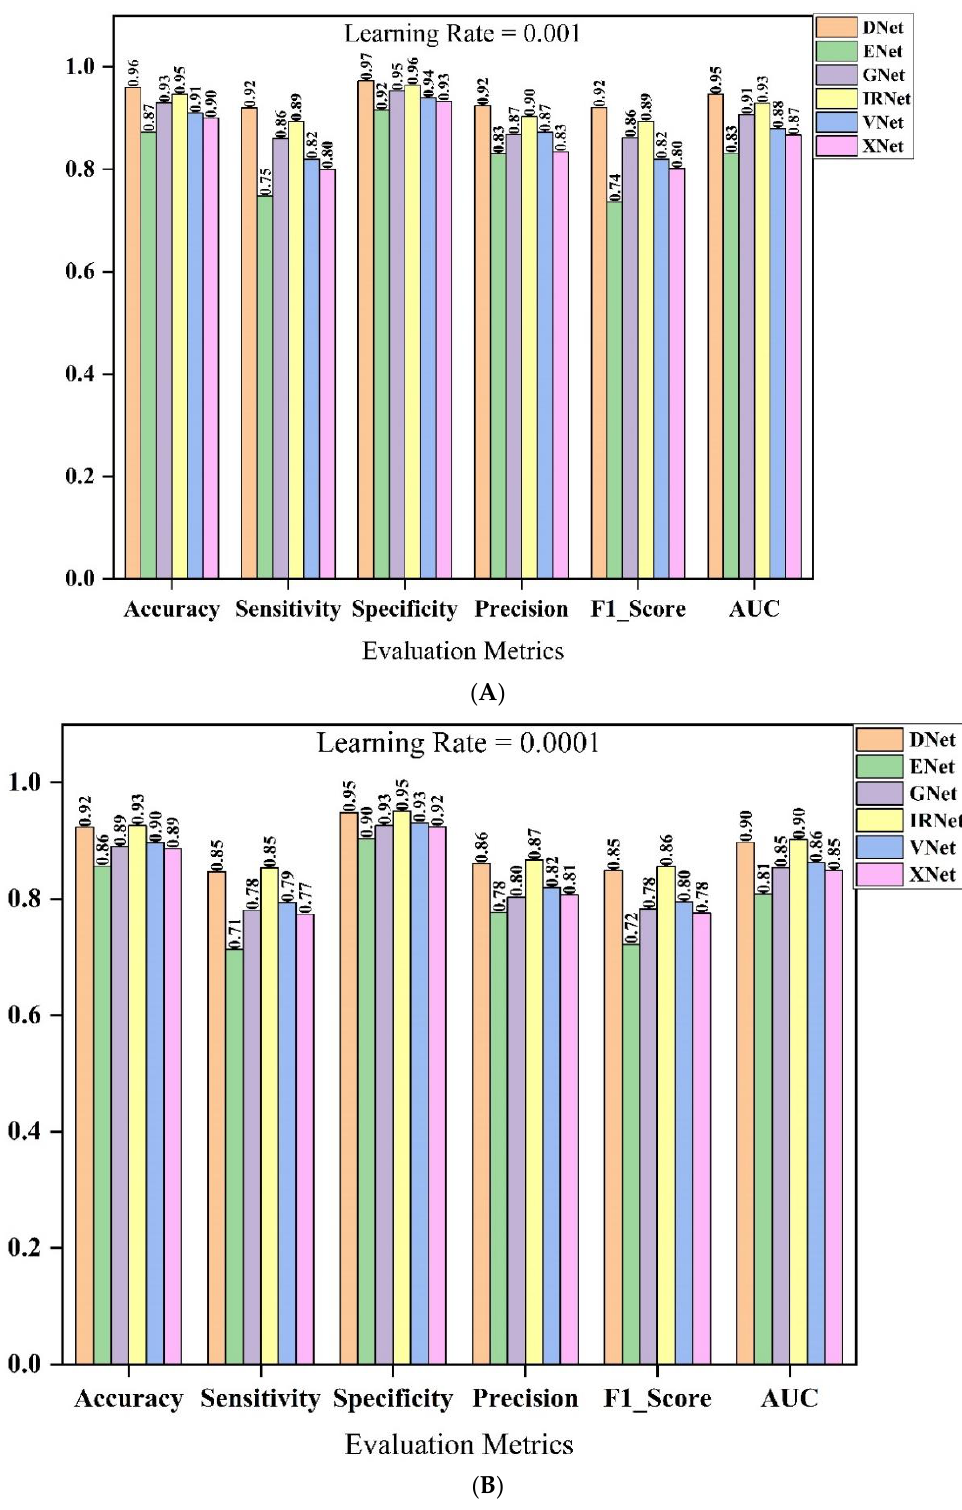
Figure 5. Classification performance result of the pre-trained models for the backbone selection using the Data_A. ( A ) Pre-trained model selection using a learning rate of 10 −4 and ( B ) Pre-trained model selection using a learning rate of 10 −3 . DNet stands for DenseNet201, ENet stands for EfficientNetB7, GNet stands for GoogleNet, IRNet stands for InceptionResNetV2, VNet stands for VGG16 and XNet stands for Xception, respectively.